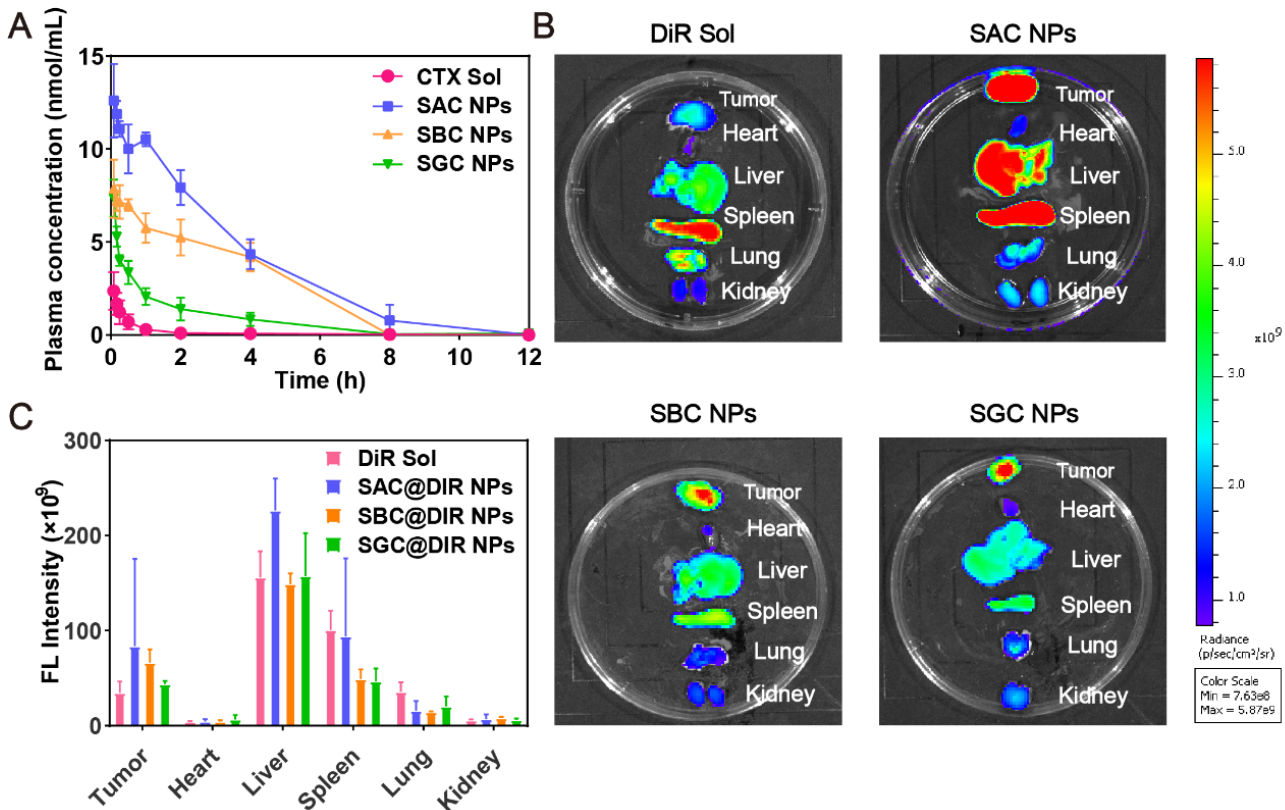
Figure 4. In vivo pharmacokinetics and biodistribution. ( A ) Molar concentration-time curves of CTX solution and NPs ( n = 5); ( B ) Fluorescent imaging of DiR solution or DiR-labeled prodrug nanoassemblies in tumors and main organs at 24 h; ( C ) Quantitative analysis of fluorescent signals in tumors and main organs ( n = 3).